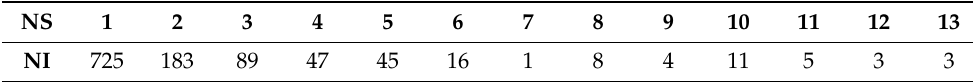
Table 2. Correspondence between NS (number of ships) and NI (number of images) in the SSDD